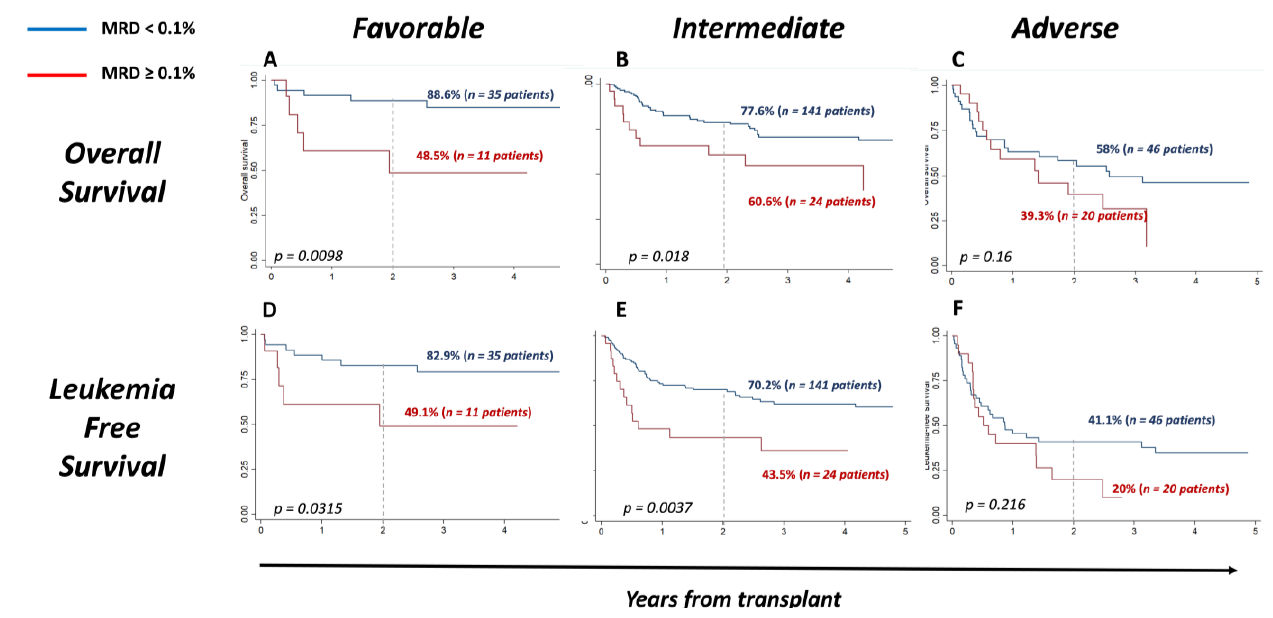
Figure 3. Impact of MRD in OS and LFS according to risk group ELN2011: survival was significantly worse in patients with MRD ≥ 0.1 in favorable ( A , D ) and intermediate groups ( B , E ). However, no differences were observed in the adverse risk group ( C , F ).